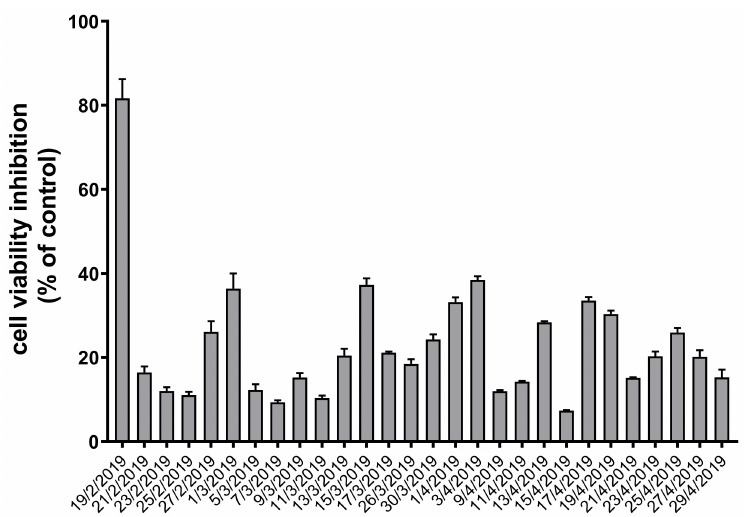
Figure 2. Cytotoxicity of PM 10 expressed as % cell viability inhibition assessed by the MTT test on A549 cells exposed for 24 h to PM 10 aqueous